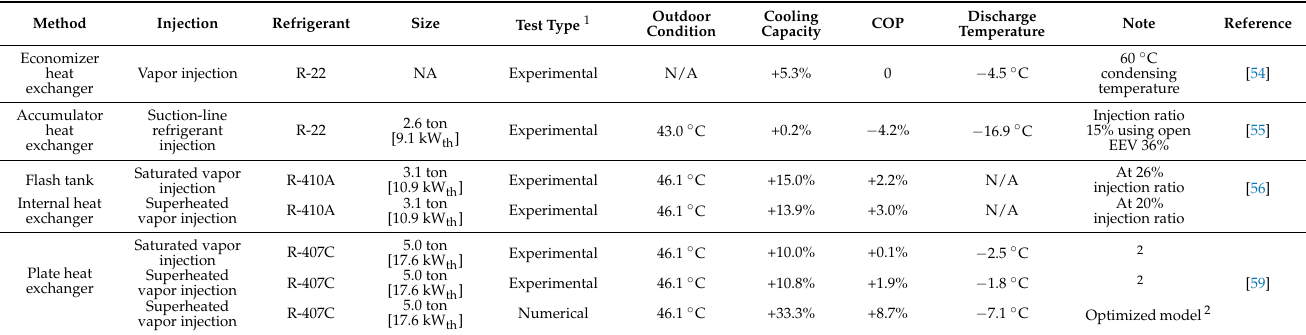
Table 8. Details of compressor improvements for each method.